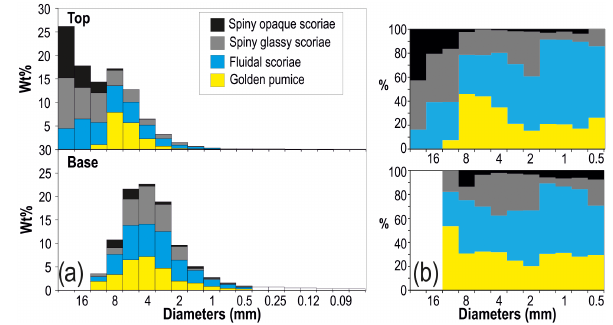
Figure 5. Proportion of each type of clast measured from the base to the top of the 10cm thick deposit emplaced during the erup- tion, at the MV site. The deposit is dominated by Hawaiian-like lapilli fragments at the base (golden pumice and fluidal scoria) and Strombolian-like bombs and lapilli at the top (spiny scoria): (a) componentry within the different grain size classes; (b) normal- ized componentry composition from the base to the top of the de- posit.